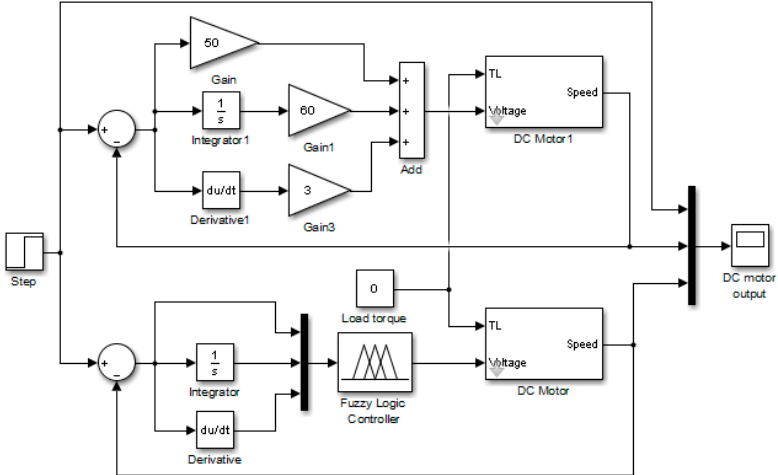
Figure 13. The control system of the PID controller and the proposed optimal fuzzy PID controller.